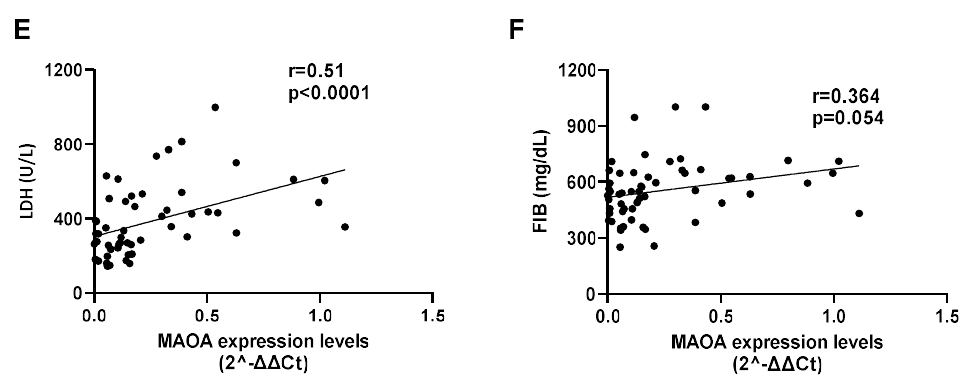
Figure 11. Correlation between the mRNA levels of ( A,B ) DDC , ( C,D ) dACE2 , and ( E,F ) MAOA with the protein levels of LDH and FIB respectively, in whole blood samples of hospitalized COVID-19 patients. Data are presented as XY scatter plots and fitted linear regression lines. Pearson’s or Spearman’s correlation coefficient (r) and p -values (p) were calculated.